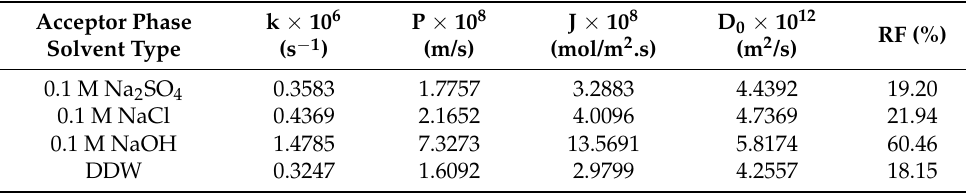
Table 4. Effect of acceptor phase solvent type on the transport of boron.